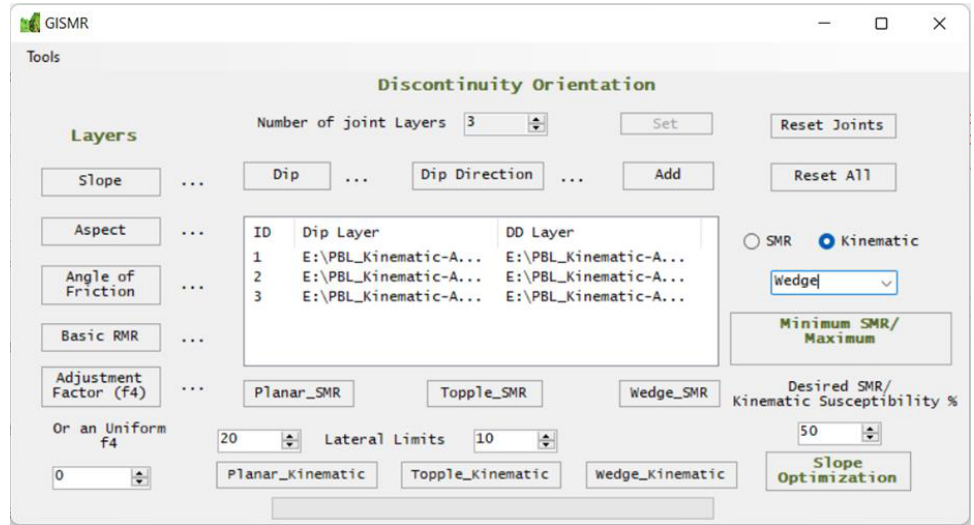
Figure 3. A screenshot of GISMR GUI showing all the input options and function buttons designed in the application.